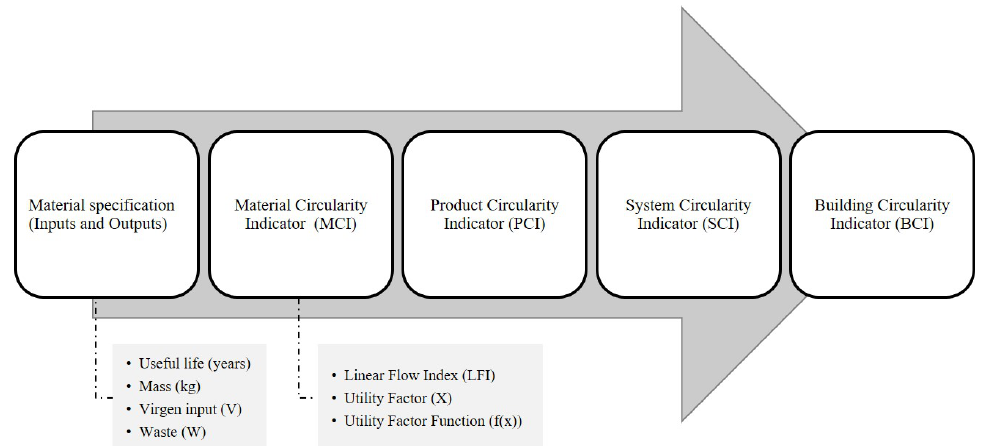
Figure 1. Circularity metrics calculation flow.